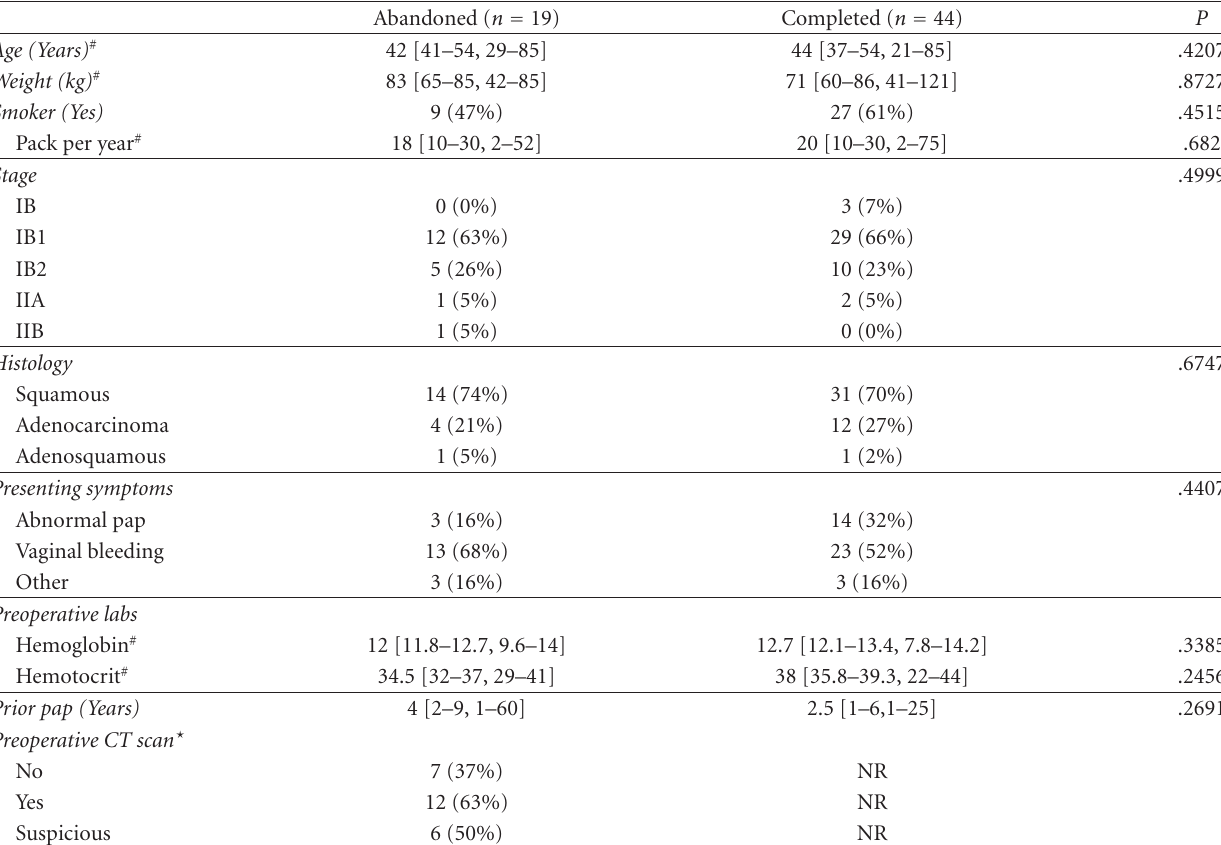
Table 1: Patient characteristics.